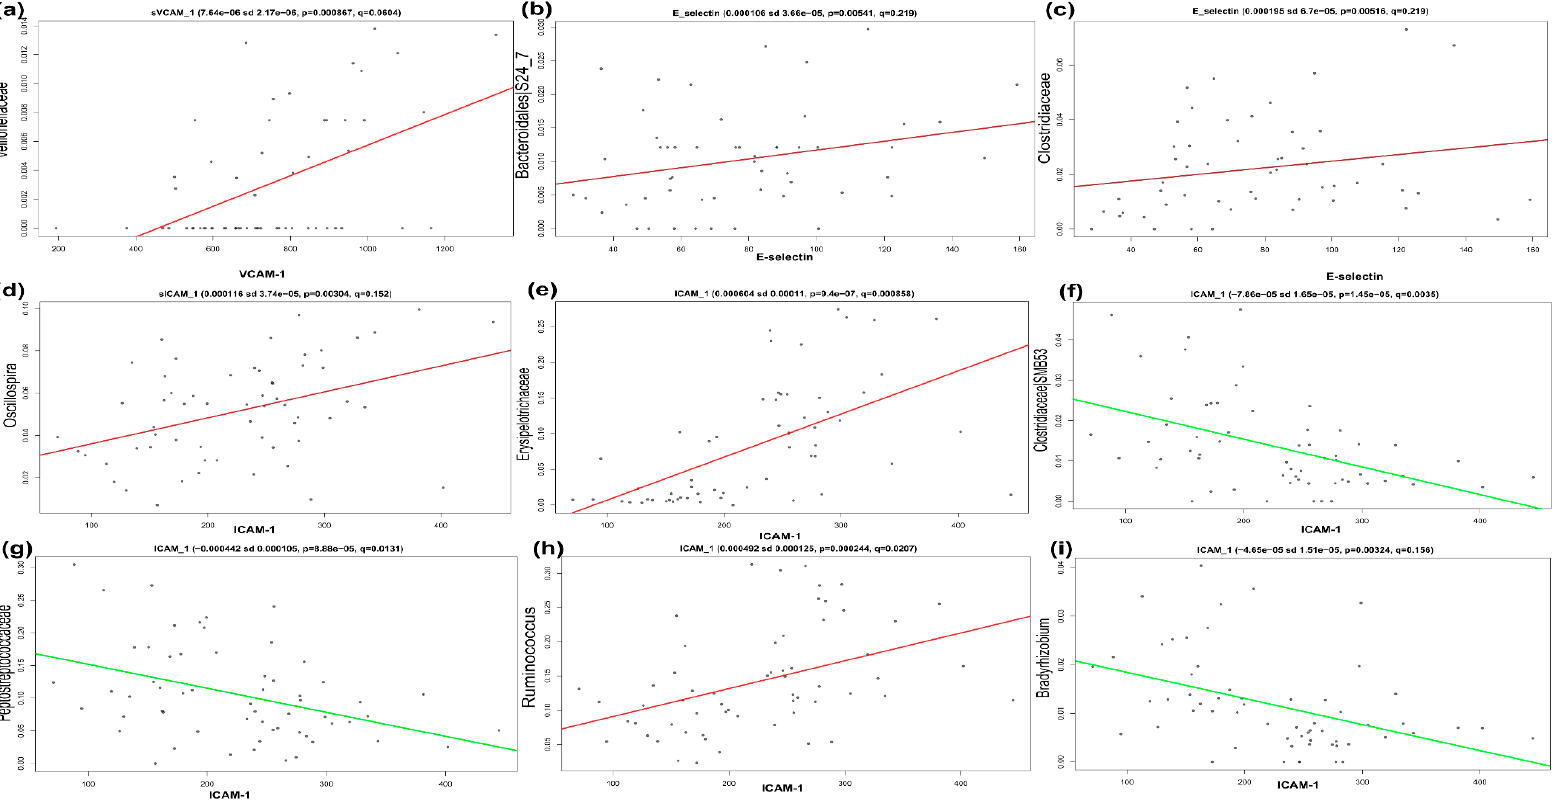
Figure 4. Multivariate linear associations of clinical metadata and bacterial relative abundance in obese children. Scatter plots show the significant associations of vascular cell adhesion molecule 1 (VCAM-1) with Veillonellaceae ( a ), E-selectin with S24-7 (family Bacteroidales) ( b ), E-selectin with Clostridiaceae ( c ), intercellular adhesion molecule 1 (ICAM-1) with Oscillospira ( d ), ICAM-1 with Erysipelotrichaceae ( e ), ICAM-1 with SBM53 ( f ), ICAM-1 with Peptostreptococcaceae ( g ), ICAM-1 with Ruminococcus ( h ), and ICAM-1 with Bradyrhizobium ( i ), as described in Materials and Methods section and Table S6. y-axes show the relative abundance of gut microbiota; x-axes show the clinical metadata. Numerical data on top of each graphic are Coefficient (positive coefficient shows positive association, and negative coefficient shows negative association between metadata and gut microbiota), sd—standard deviation; p -values; e—times 10 is raised to the power of, and FDR corrected q -values which are assigned by MaAsLin (v0.0.4). VCAM-1-vascular cell adhesion molecule-1, and ICAM-1-intercellular adhesion molecule-1.